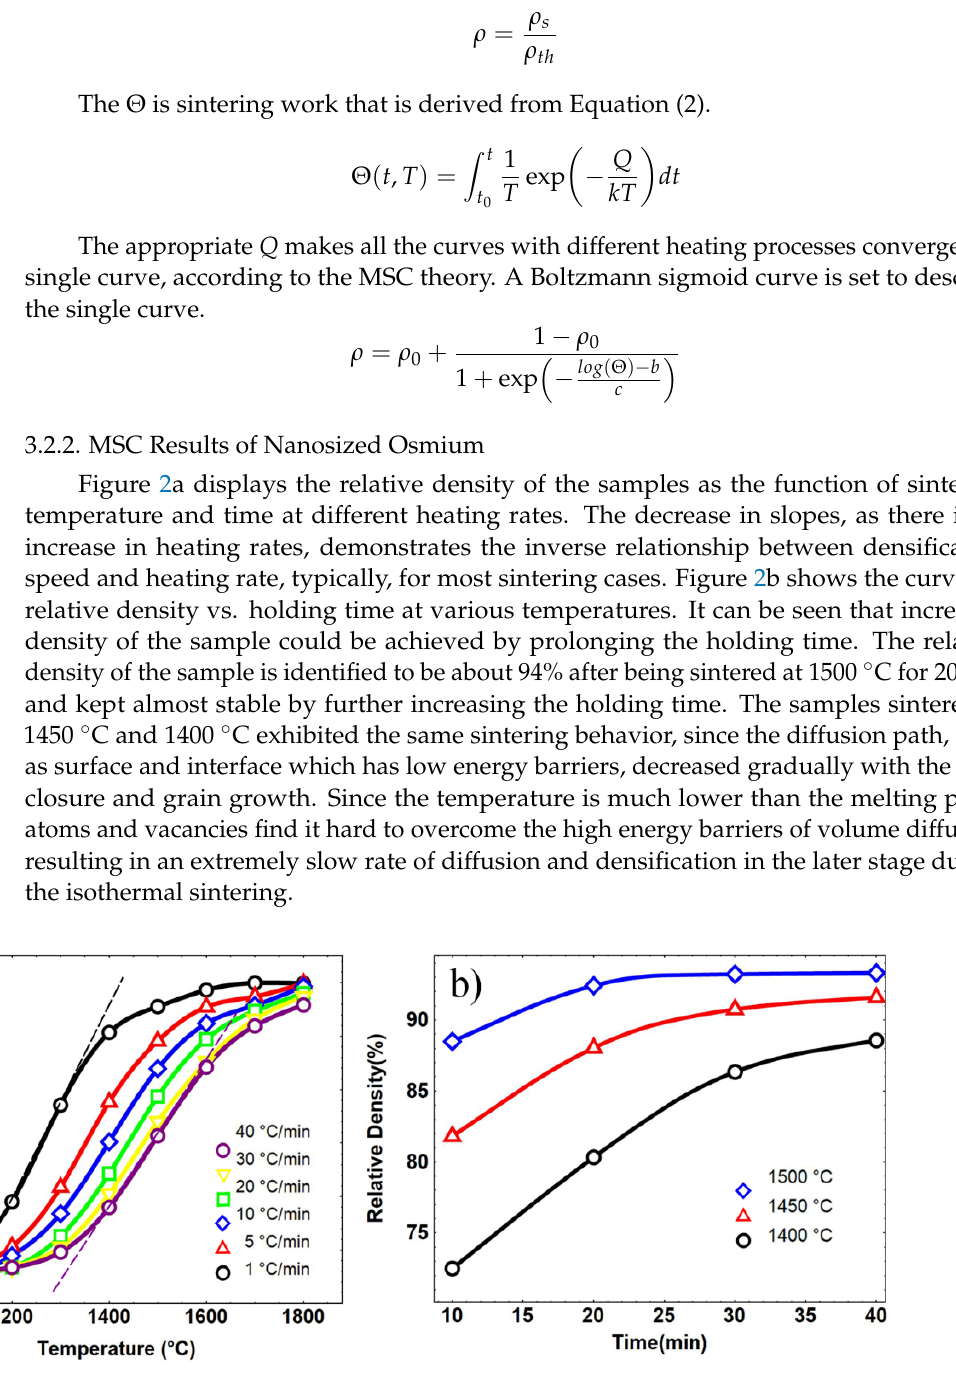
Figure 2. Densification tendency of samples prepared at ( a ) different heat-ramp rate, ( b ) isothermal duration at different temperatures.